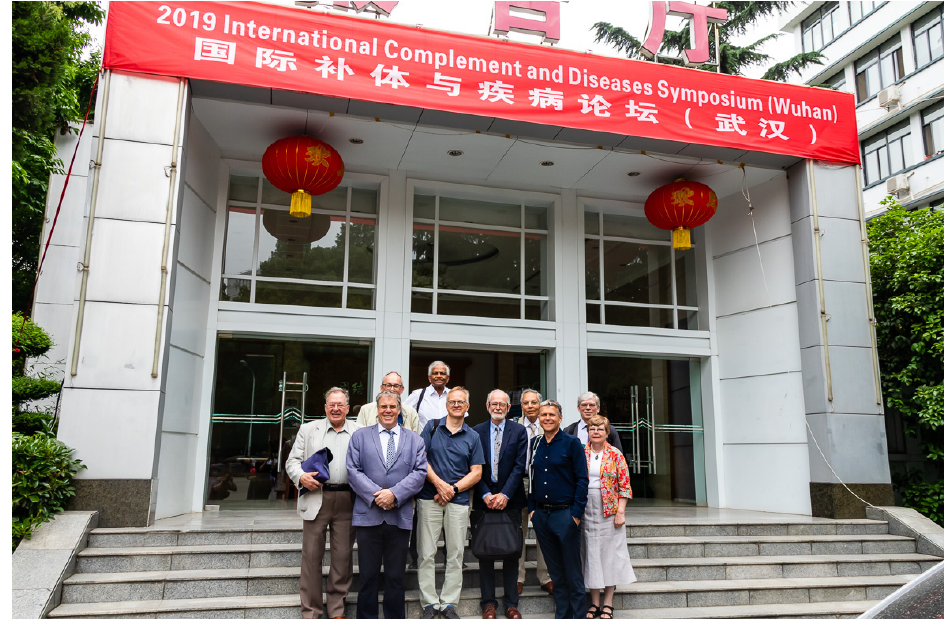
Figure 2. The EU complement consortium (picture taken at the International Complement and Diseases Symposium in Wuhan, 13 May 2019) with Bob (far left) making a joke so everyone was laughing, from left to right, R. Würzner, J. Wieslander, M.R. Daha (overlooking the group), Y. Sommarin, M.W.